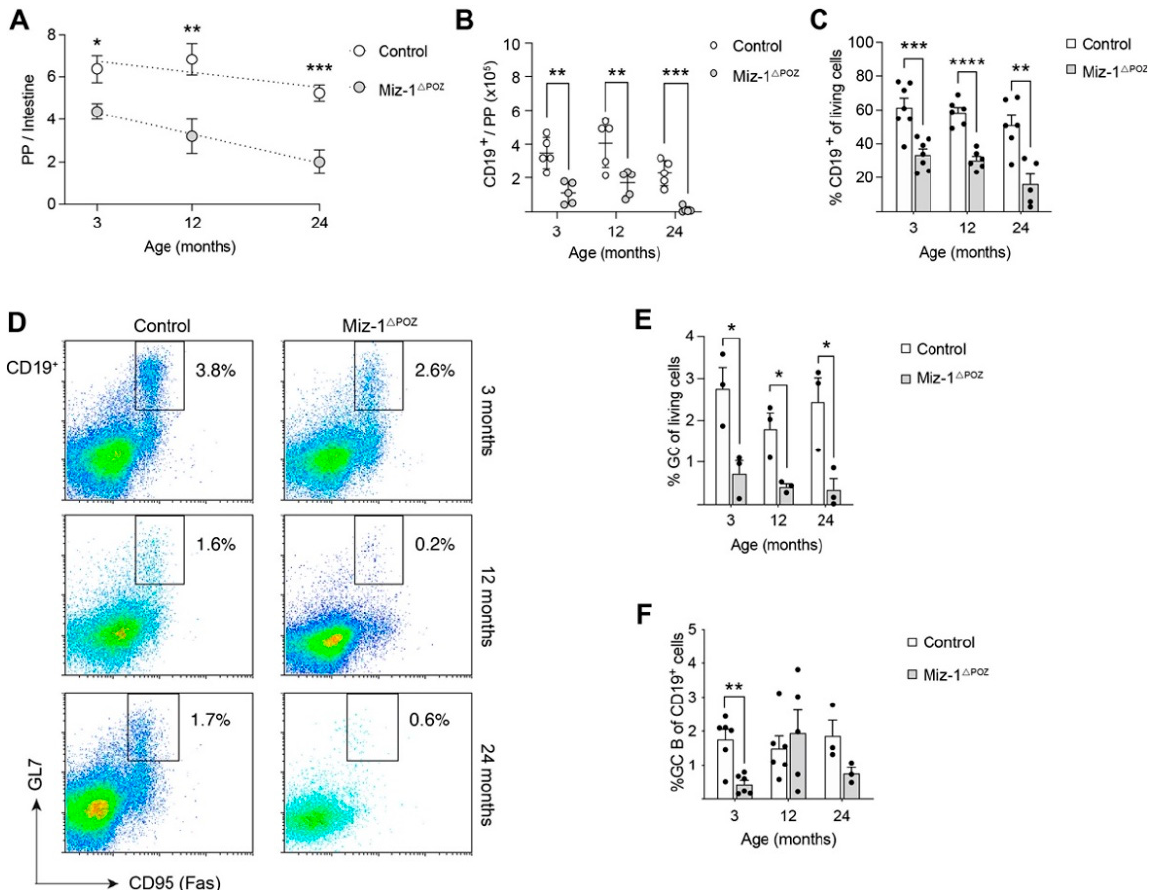
Figure 5. Non-functional Miz-1 leads to reduction in intestinal immunity. ( A ) Number of macroscopic Peyer’s patches (PPs) per intestine. Data are expressed as mean ± SEM ( n ≤ 5). ( B ) Cell count of B cells (CD19 + ) from the intestine. Cells were counted and calculated to the number of PP/intestine. ( C ) Frequency of CD19 + cells in PPs analyzed by flow cytometry. ( D ) Flow cytometric analysis of lymphocytes from PPs of control and Miz-1 ∆ POZ mice. Cells were analyzed with antibodies for CD19, GL7 and CD95 (Fas). Percentages in plots are given for the respective gates as percentage of CD19 + cells. ( E ) Frequency of GC B cells (CD19 + GL7 + CD95+) in PPs from D. ( F ) Frequency of GC B cells in relation to CD19 + cell from PPs. Each point represents one mouse. Data are expressed as mean + SD ( n ≥ 3). Student’s unpaired t -test: * p < 0.05, ** p < 0.01, *** p < 0.001, **** p < 0.0001. For ( D ), plots are representative of at least three independent experiments.